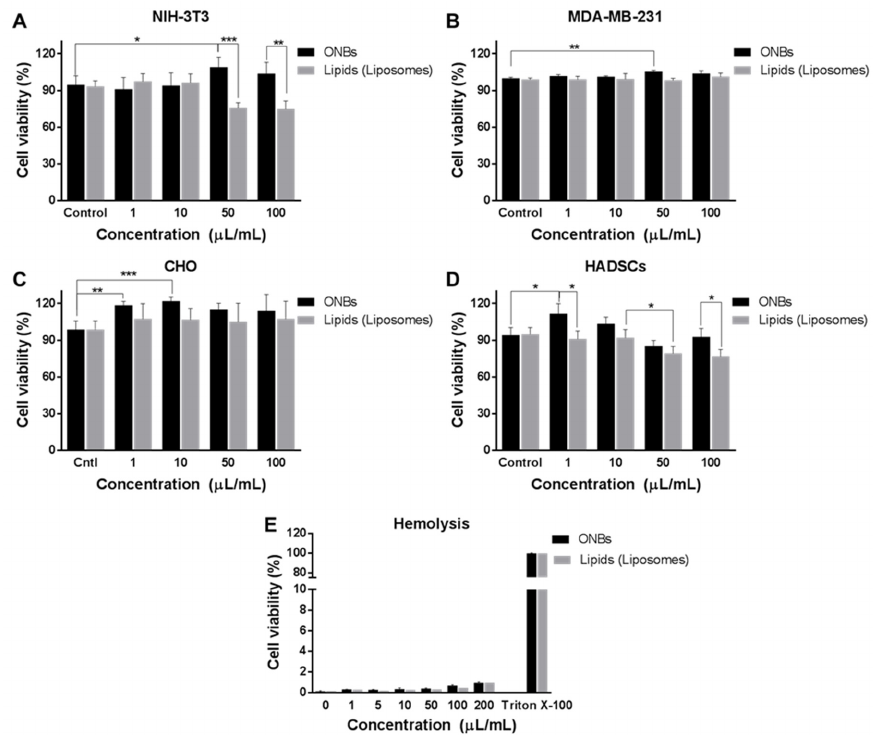
Figure 3. Cell viability test for ONBs determined through CCK-8. Cell viability of various concentrations of ONBs and lipids in NIH-3T3 ( A ) in MDA-MB-231 ( B ), in CHO ( C ) and in HADSCs ( D ) cell lines. ( E ) Hemolysis experiment for ONBs and lipids. Here, *, **, and *** highlight p-values of less than 0.05, 0.01, and 0.001, respectively.